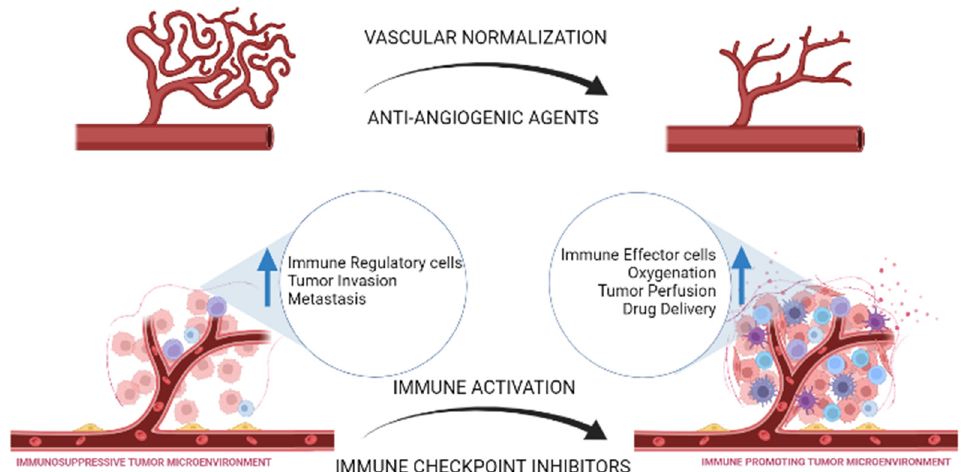
Figure 2. Highlighting the parallel between anti-angiogenic agents and immune checkpoint inhibitors in their effect on the tumor microenvironment and how it impacts tumor progression and drug delivery. Created with BioRender.com (accessed on 16 February 2022).